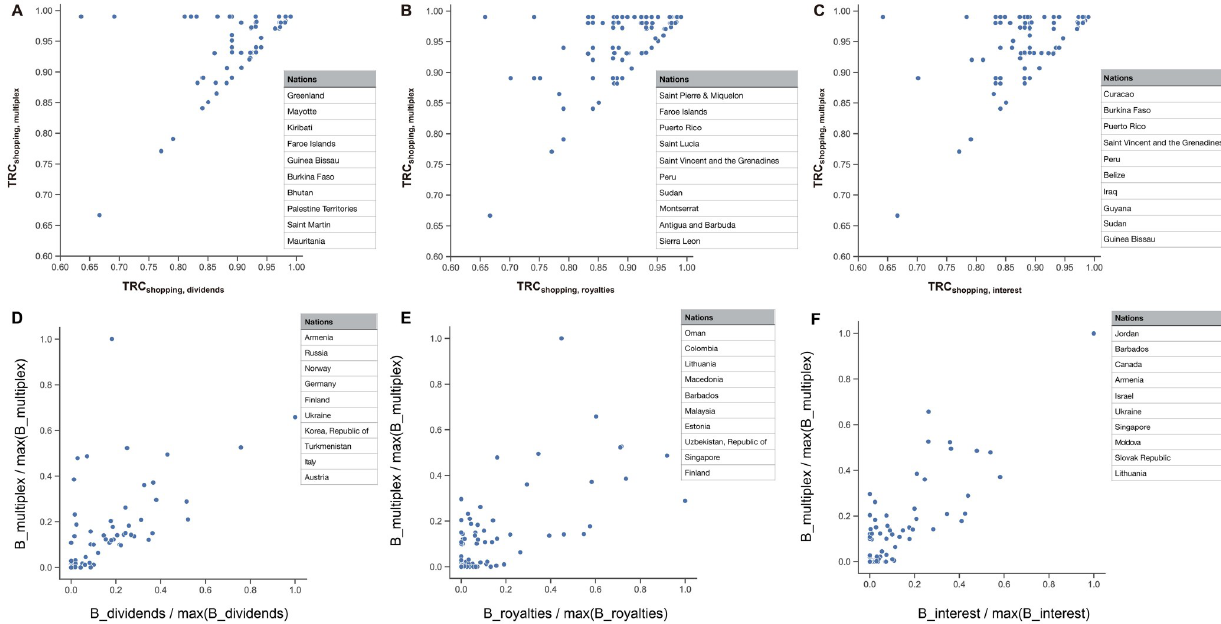
Fig 4. Comparison between the multiplex network and each single layer. Comparison of TRC values (A-C) and betweenness centrality (D-F) between the multiplex network and three income layers. The top 10 countries with the highest ratios between the multiplex network and each single layer are presented in the inset tables in order from largest to smallest